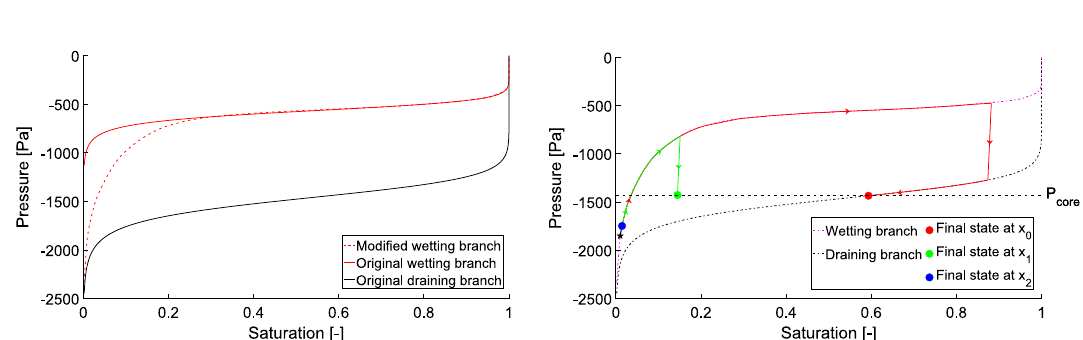
Figure 4. Evolution of the pressure-saturation states of three blocks x 0 (core), x 1 (between the core and the fringe), and x 2 (outer block of the fringe) during the first 12 minutes of the simulation. All three points started at the location denoted by a black pentagram. See the text for details.